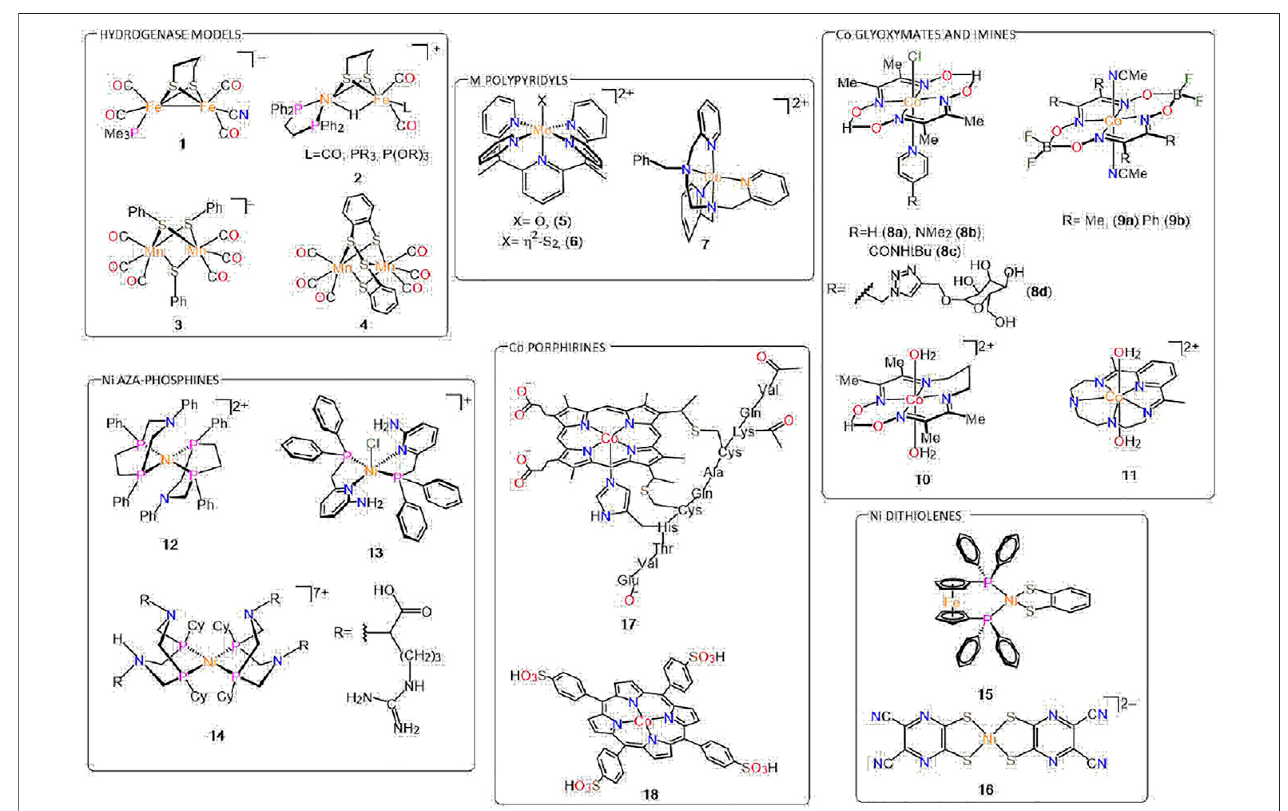
FIGURE 3 | Structures of hydrogen evolution catalysts 1 – 18